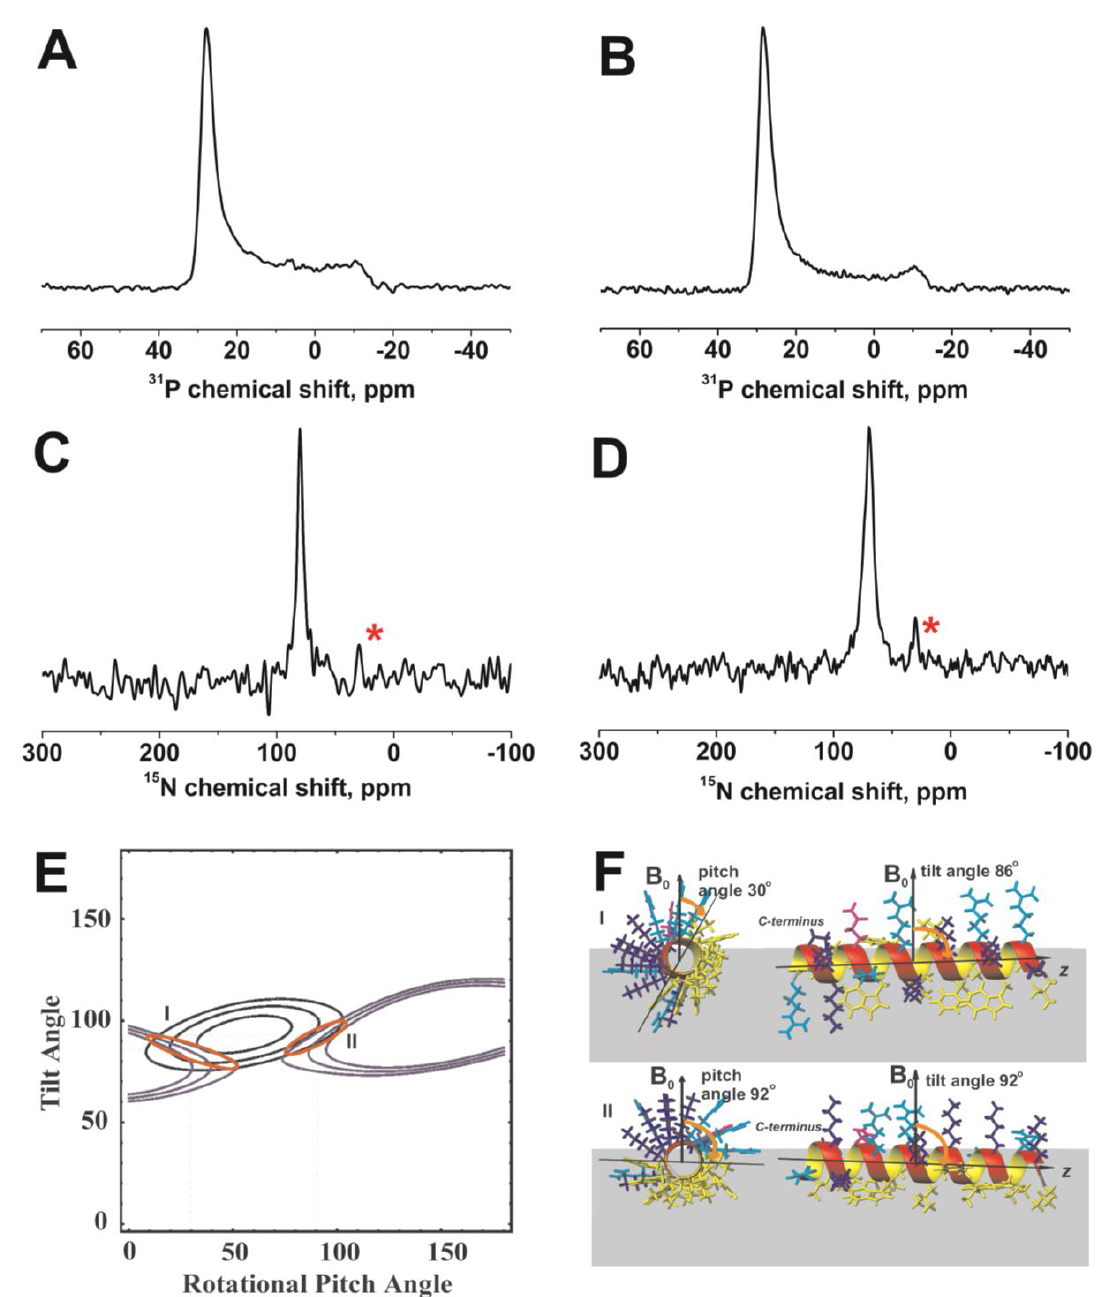
Figure 3. Proton-decoupled 31 P ( A , B ) and 15 N ( C , D ) spectra of 2 mol% SAAP-148 carrying 15 N label in position Leu11 ( A , C ) and Leu12 ( B , D ) in POPE:POPG 3:1 at 310 K. The 15 N signal from the PE headgroup at natural isotope abundance is indicated by asterisks in panels C and D. ( E ) Restriction analysis and corresponding peptide alignments relative to the membrane normal ( F ) for 2 mol% SAAP-148 in POPE:POPG 3:1 bilayer. The resulting restrictions for SAAP-148 topology are shown in panel E: 15 N-Leu11 is 80.0 ± 2.5 ppm in blue, and 15 N-Leu12 is 70.0 ± 4.0 ppm in green. The restraints were obtained assuming rocking (18° Gaussian distribution) and wobbling (10°) motions of an ideal helix (φ = − 65°, ψ = − 45°). Leucines, phenylalanines, valines, tryptophan, and proline are shown in yellow, lysines in blue, glutamines in magenta, and arginines in cyan. Two possible intersections are obtained in ( E ) (orange ellipses), both are represented in panel ( F ) (note that the perfect helix shown in panel F does not represent an experimental structure but a way to show the axis orientation in the assumption of alpha helix conformation).